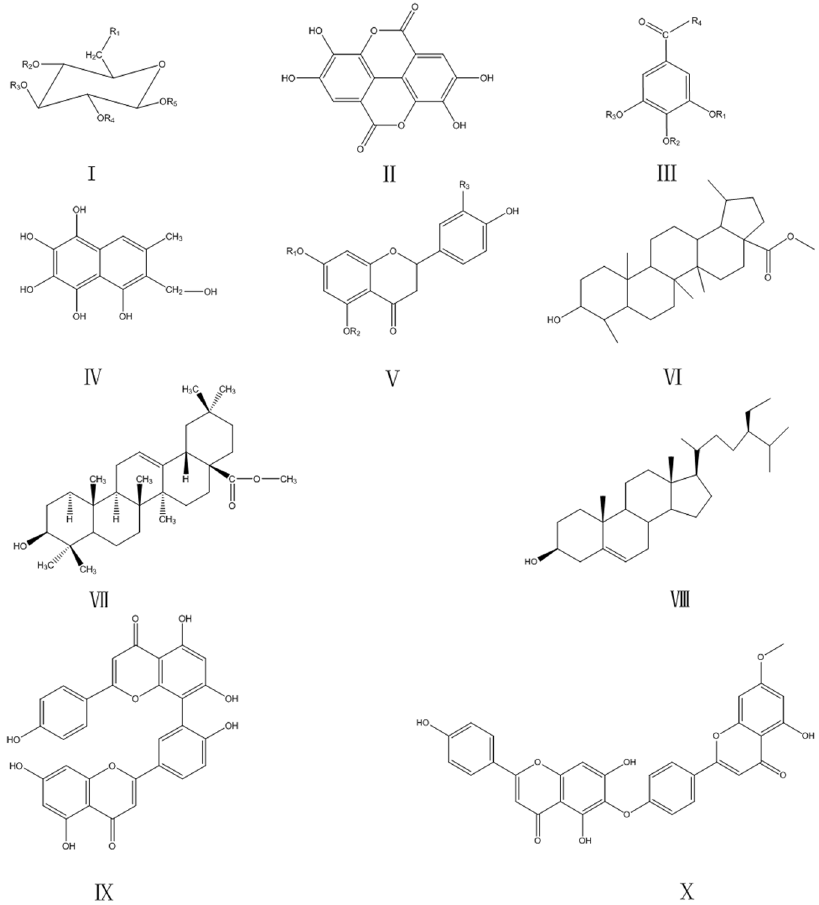
Figure 2. Turkish galls: 10 types of bone structure